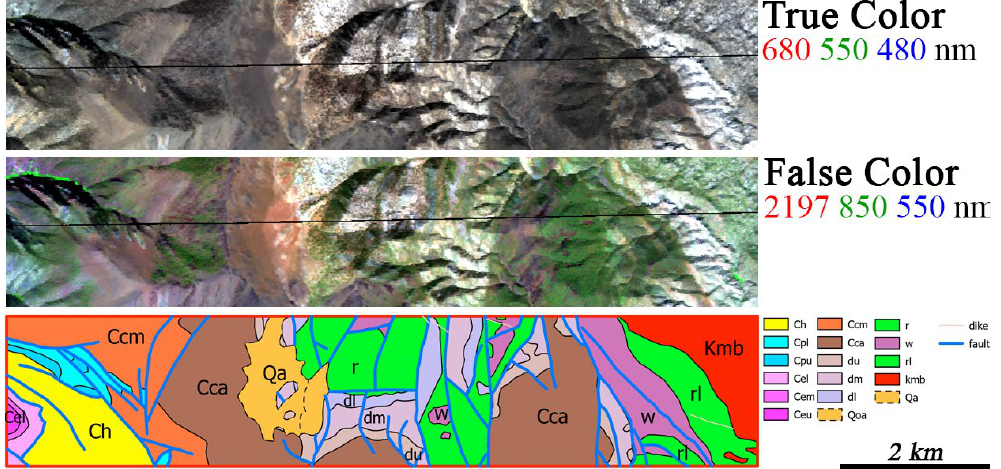
Figure 2. The Schulman Grove study area. Top and center images show true color and false color AVIRIS band combinations, respectively. Black line trending ESE-NNW across the center of these images was excluded from subsequent analysis due to nonphysical reflectance values. Bottom frame shows bedrock geology of the same area from [58]. Geologic units are described in more detail later in this paper. Ch: Harkless Formation; Cpl and Cpu: lower and upper members of Poleta Formation, respectively; Cel, Cem, Ceu: lower, middle, and upper members of Emigrant Formation, respectively; Ccm and Cca: Montenegro and Andrews Mountain members of Campito Formation, respectively; dl, dm, du: lower, middle, and upper members of Deep Spring Formation; rl and r, Lower member and undifferentiated Reed Dolomite, respectively; w: Wyman Formation; Kmb: Birch Creek Pluton; Qoa: older alluvium, Qa: alluvium.